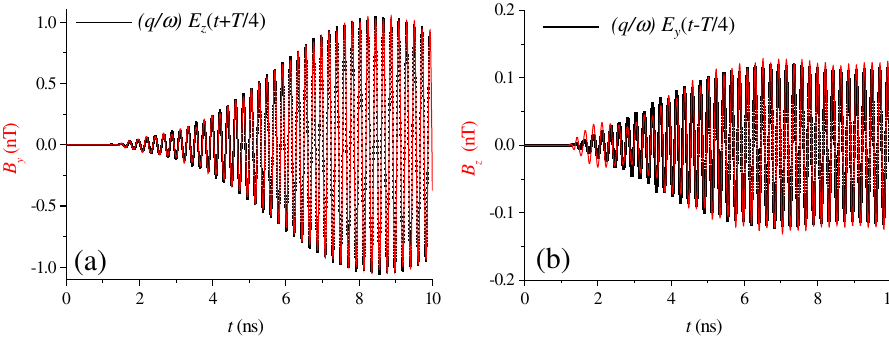
FIG. 12. Tests of the predictions given in Eq. (2.24). The rescaled and time-shifted electric field components (black) are compared with the magnetic field components (red), as determined in a 3D simulation with sidewalls at 4.7 GHz. (a) B